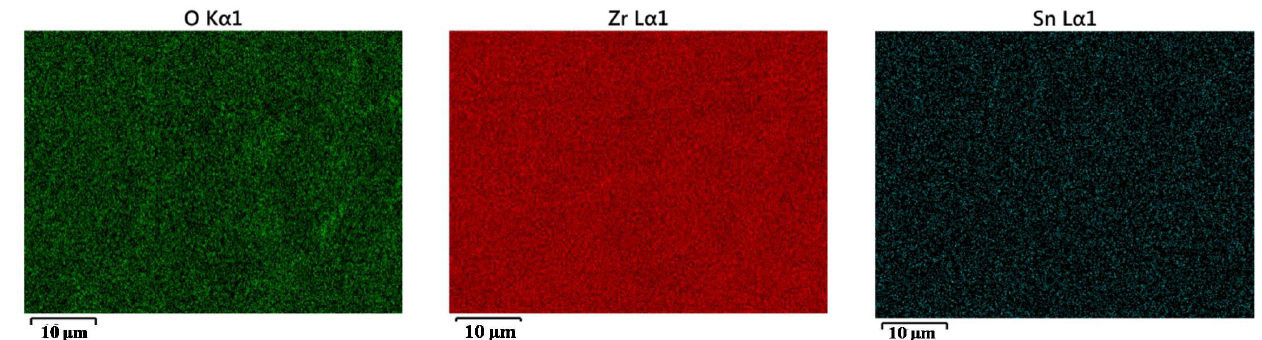
Figure 12. Microstructure after 14 days of corrosion in 400 °C high temperature and high pressure water environment of FeCrMnNi alloy.